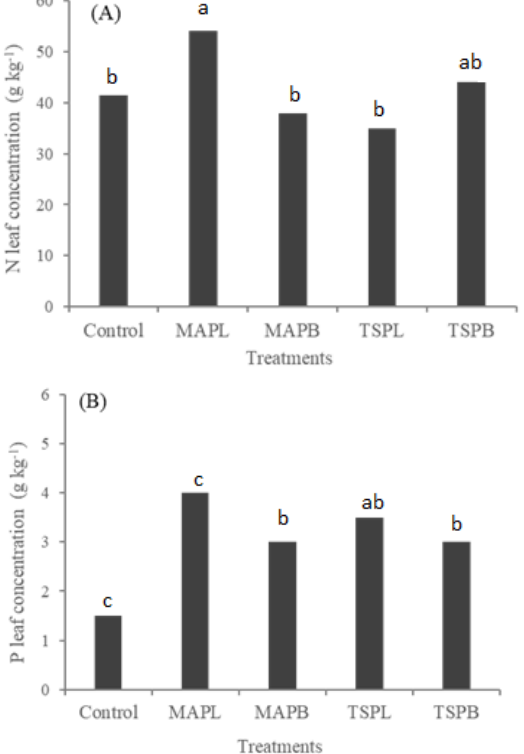
Figure 2. Soybean P ( A ) and N leaf content ( B ) as affected by P sources and application forms. Different letters denote significant difference (LSD, p ≤ 0.05). MAP L = MAP applied close to the seed furrow; MAP B = MAP broadcasted at the soil surface; TSP L = TSP applied locally within the soil; TSP B = TSP broadcasted at the soil surface. The greatest PUE was observed with localized MAP, followed by the broadcasted MAP, localized TSP, and TSP broadcasted (Figure 3). As observed for shoot dry matter yields, supplying P with either MAP or SFT locally resulted in higher PUE compared with superficial application.